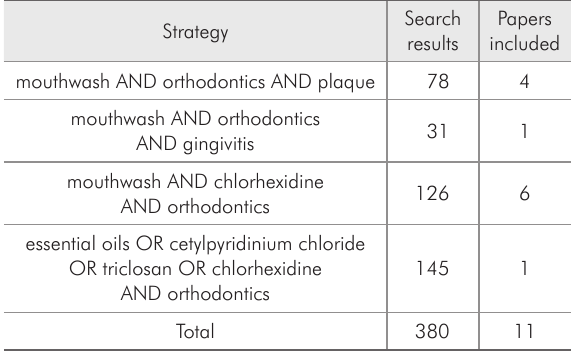
table 1 - Search results for articles eligible for the